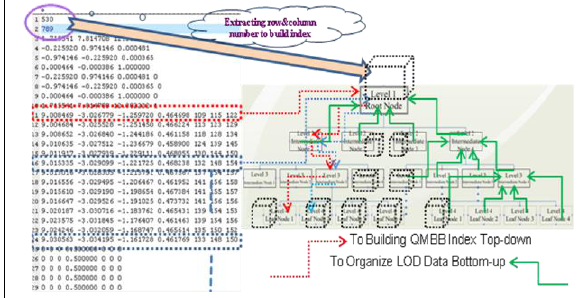
Figure 3 Construction algorithm diagram of QMBB-tree spatial index of point image